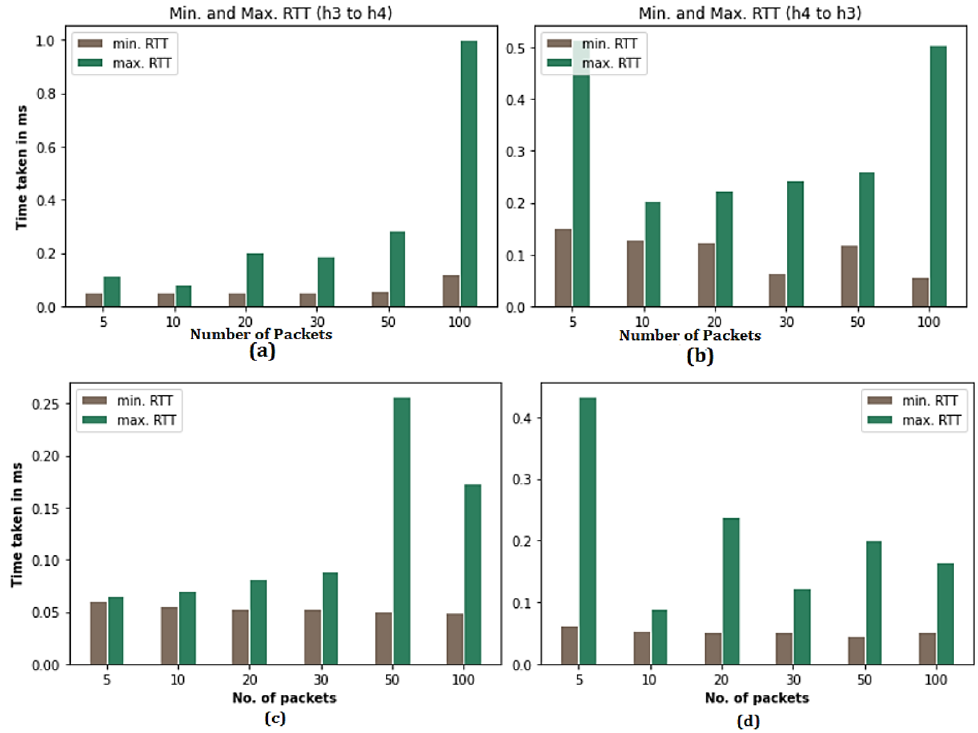
Figure 17. Min. and Max.RTT, ( a , b ) Within AS65000/SDN in Legacy, and ( c , d ) in